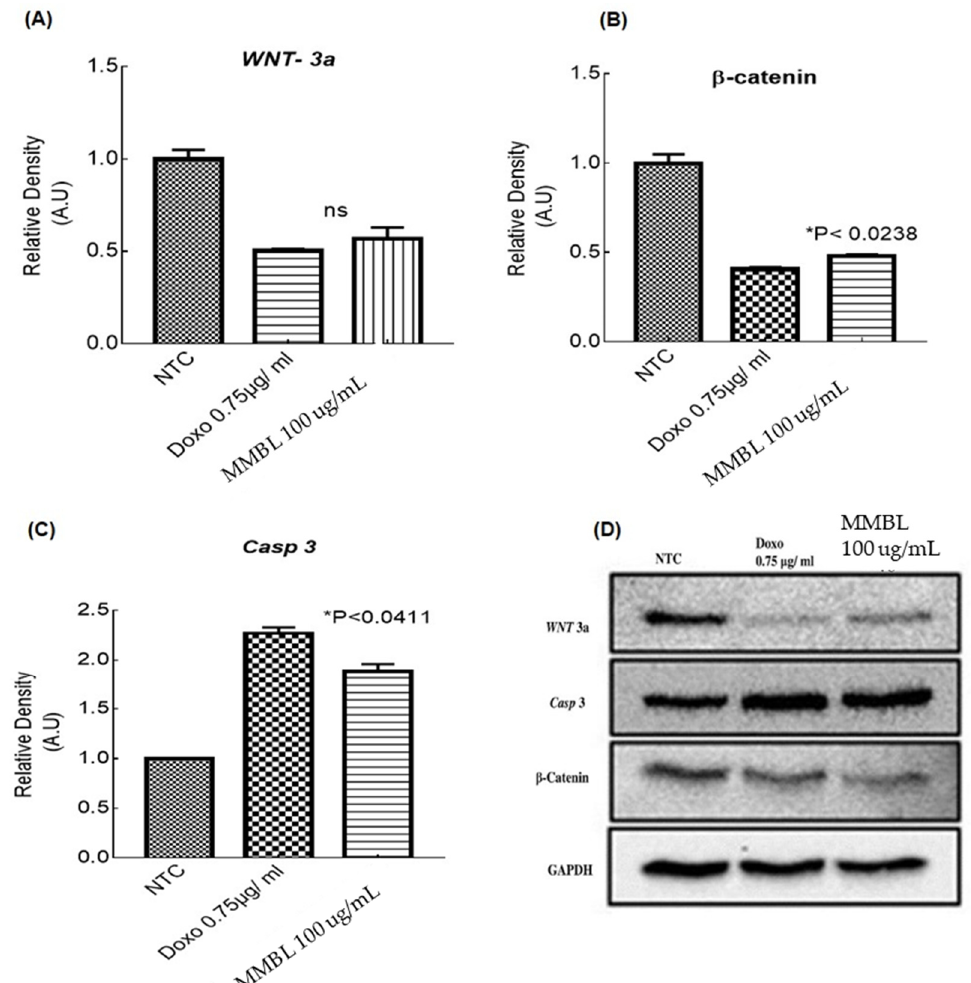
Figure 5. Effect of MMBL on WNT / β -catenin signaling by Western blot analysis. MCF-7 was treated with MMBL 100 µ g/ml and then Western blot analysis was performed. One-way ANOVA with Tukey’s multiple comparisons test between MMBL 100 µ g/ml and Doxorubicin treated cells showed ( A ) WNT-3a (ns: no significant difference), ( B ) β -catenin (* p < 0.00238) and ( C ) Caspase 3 (* p < 0.041) MCF-7 cells. GAPDH immunoblotting served as the loading control. ( D ) Western blot showing the comparative concentration of targeted